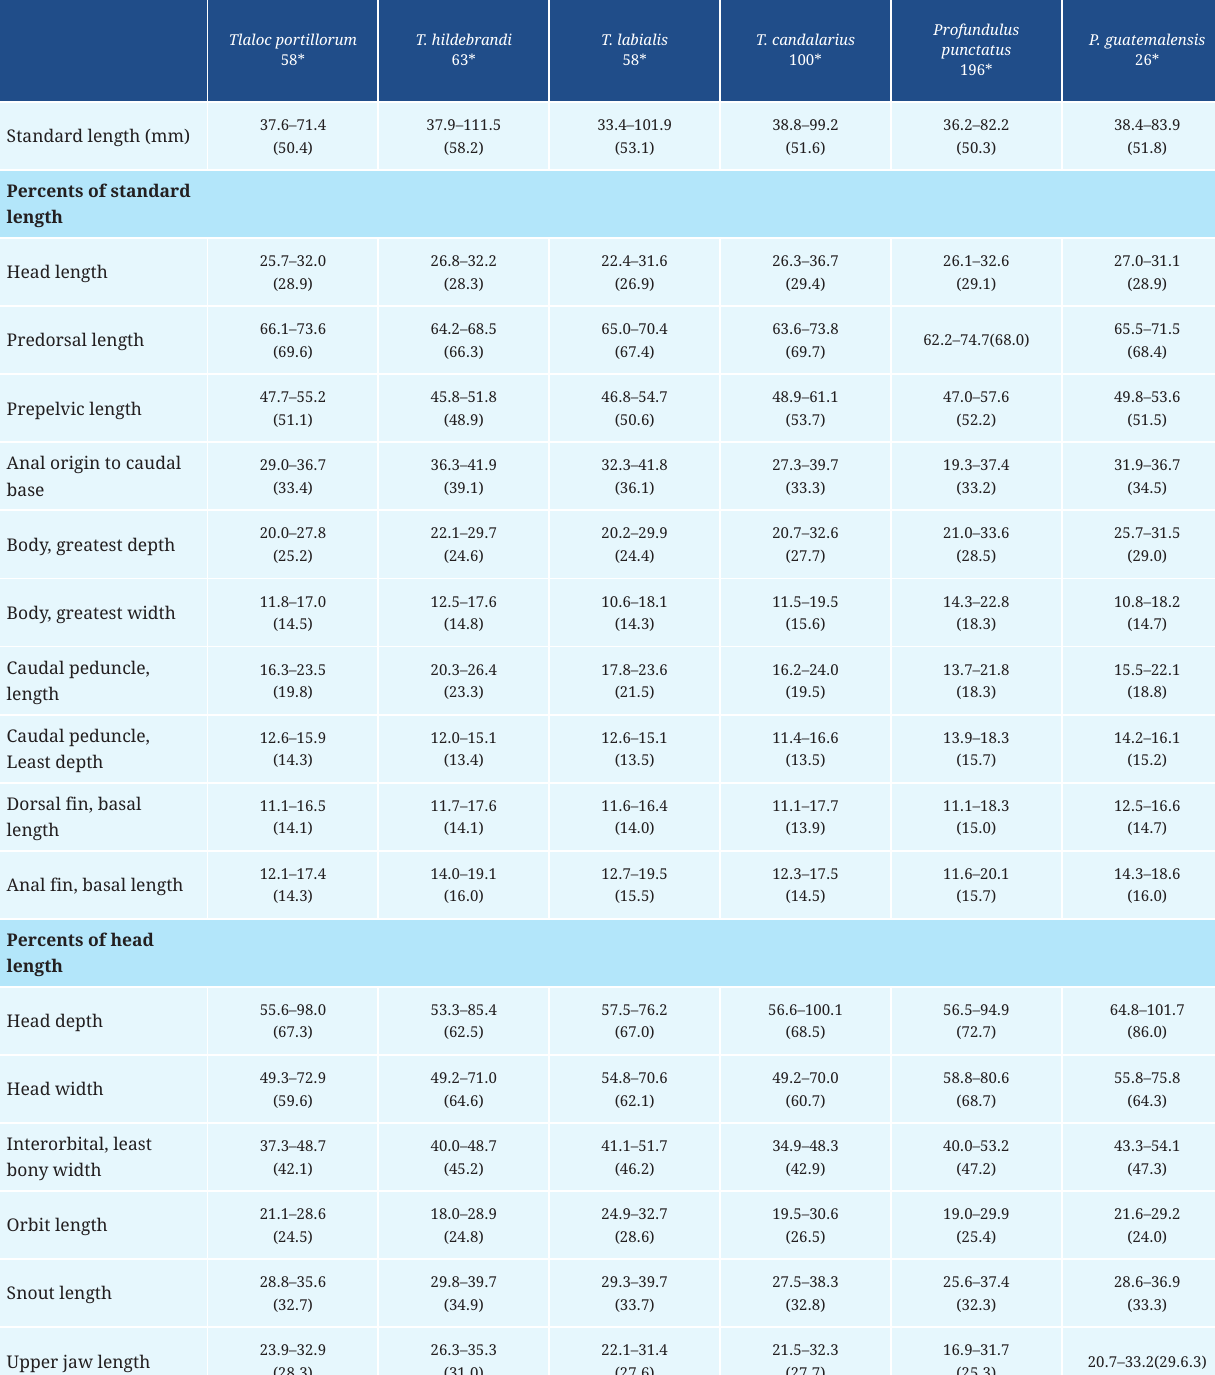
TABLE 1 | Morphometric data of Tlaloc and Profundulus species. Asterisk mark the number of specimens analyzed, in parenthesis the average